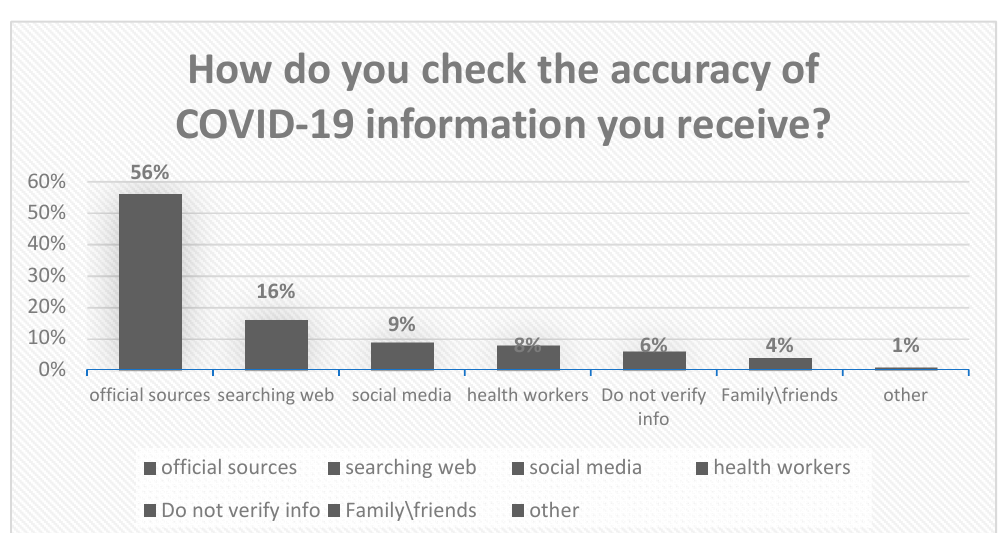
Figure 3. Distribution of the sources used for checking the accuracy of COVID ‐ 19 ‐ related information.